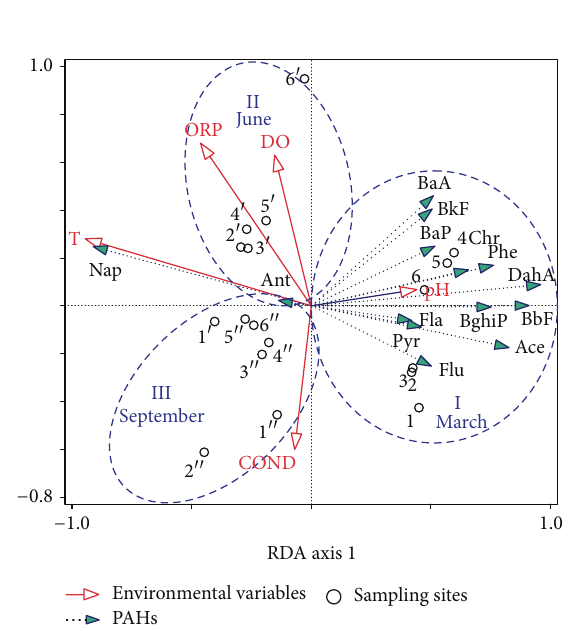
Figure 5: Redundancy analysis (RDA) plot of the relationship between environmental parameters and PAHs in March (dry sea- son), June (wet season), and September (temperate